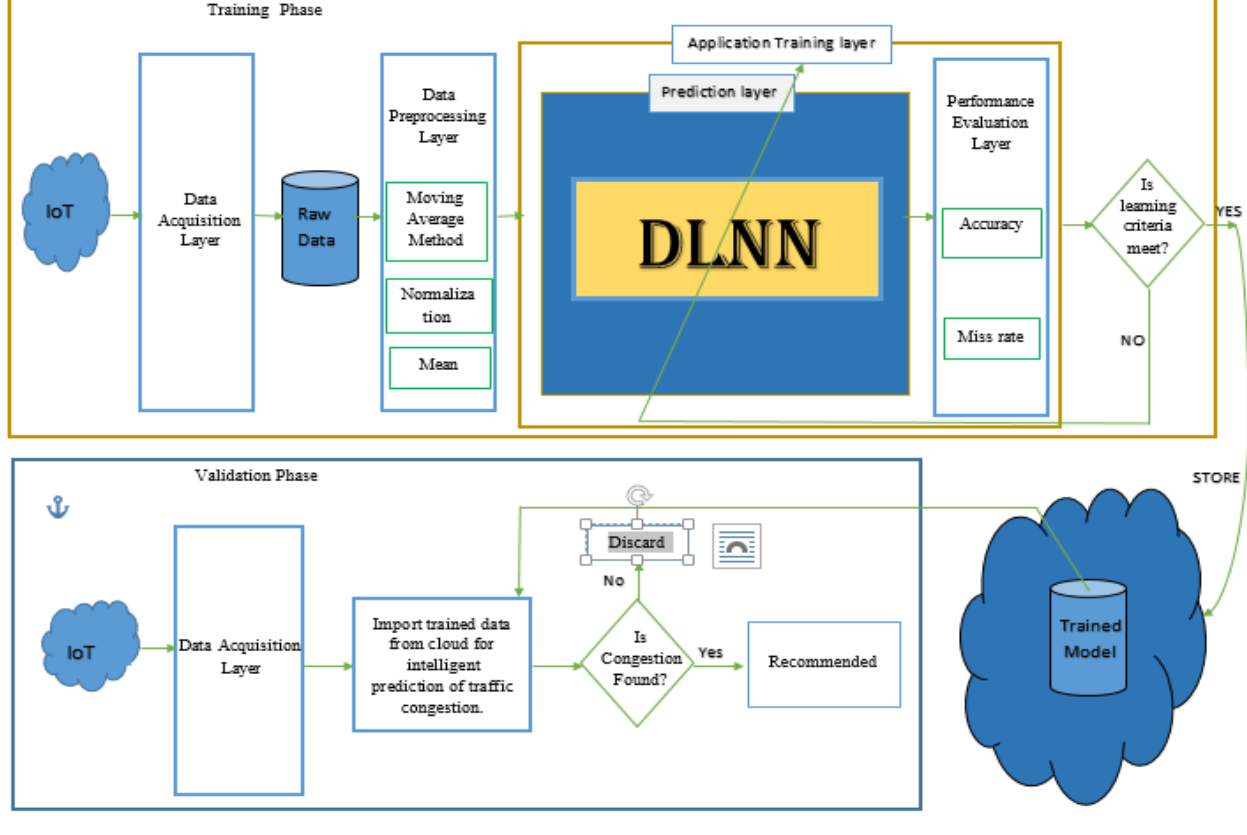
Figure 1. Proposed TC2S- DNN system